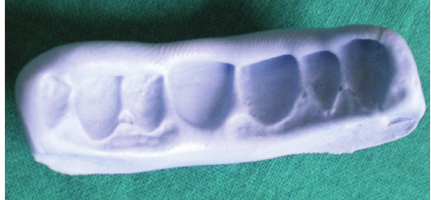
Figure 2: Putty index fabricated on cast after stabilization of pontic on cast with wax.